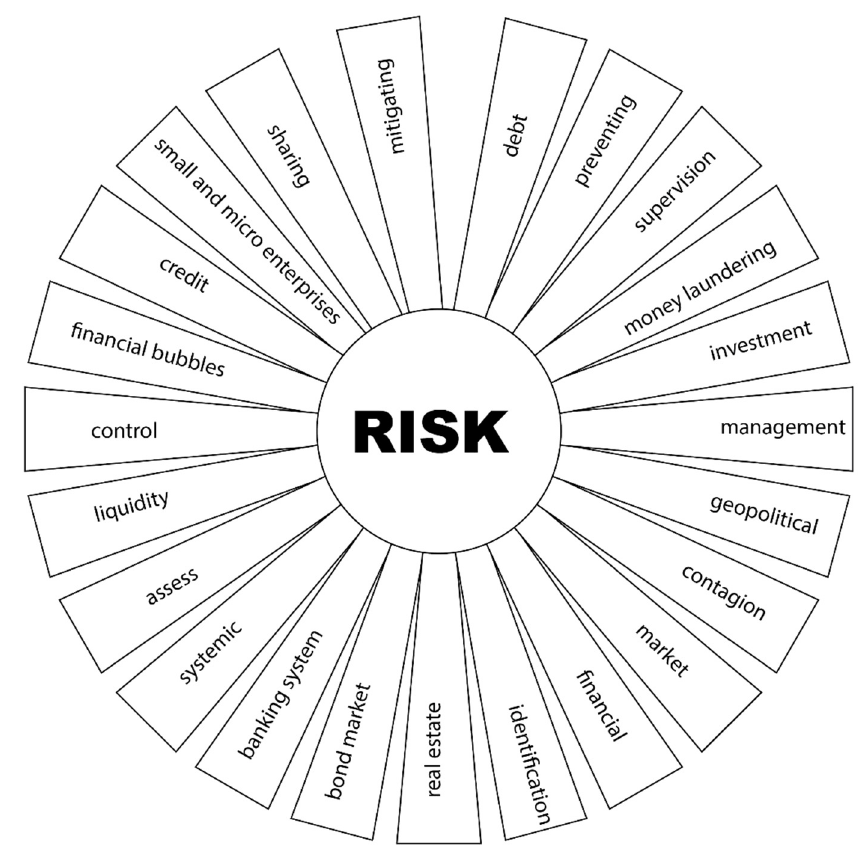
Figure 2. The network of the form “risk” of People’s Bank of China.